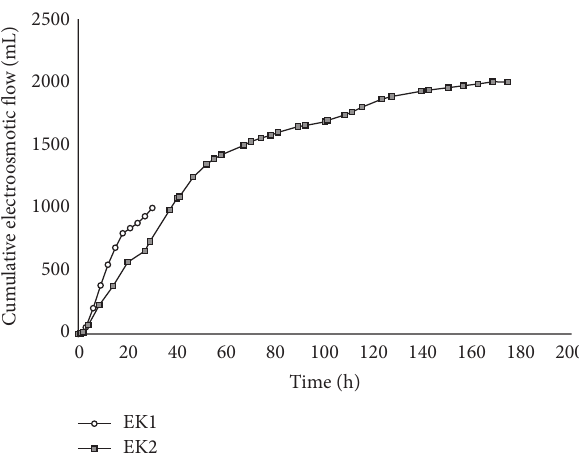
Figure 6: Cumulative electroosmotic flow ( 𝑄 ) as a function of treatment time (EK1,